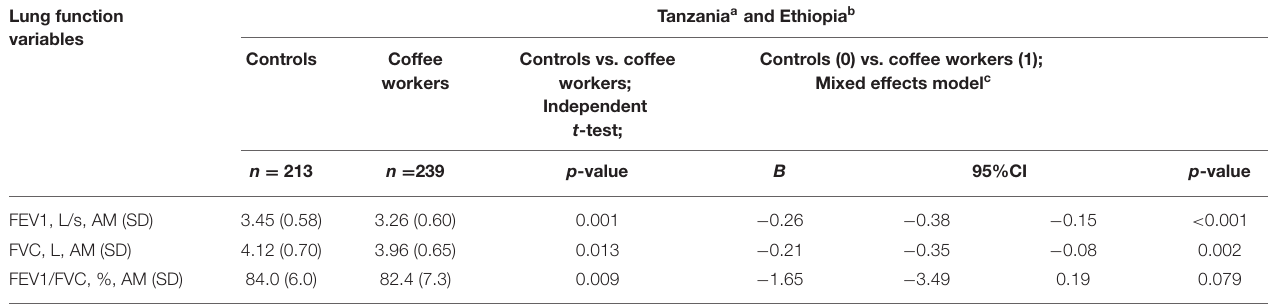
TABLE 4 | Lung function among male coffee workers in Tanzania and Ethiopia.